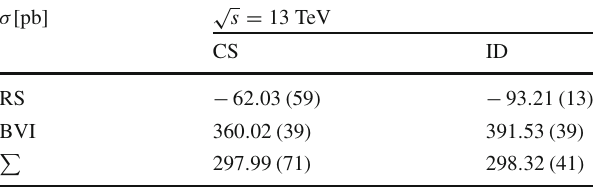
Table 2 NLO cross section for pp → W + W − j b j b at μ R = μ F = m t √ s = 13 TeV, computed using standard CS subtraction terms (CS) and orpseudo-dipoles(ID).Thesubtractedreal-emissioncontributions(RS) were calculated using 10 8 phase-space points. The Born, virtual cor-